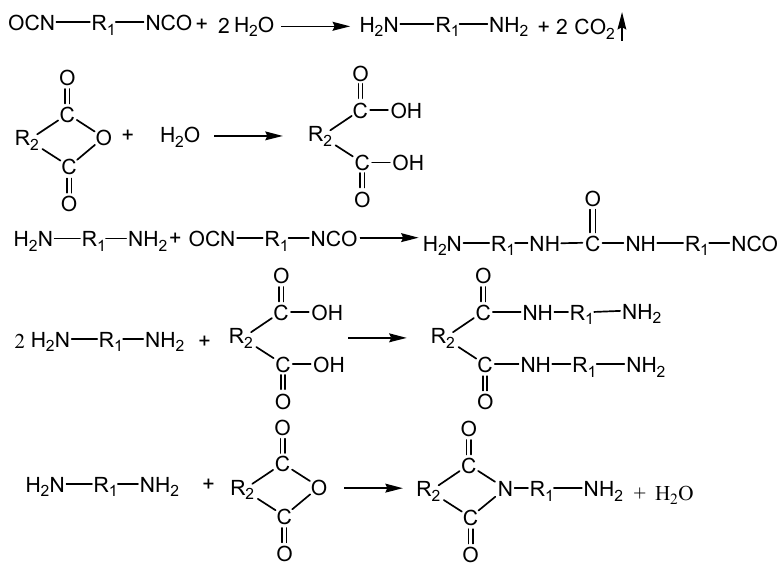
Scheme 1. The schematic diagram of the boiled foaming reaction mechanism of universal cross-linked PVC structural foam.